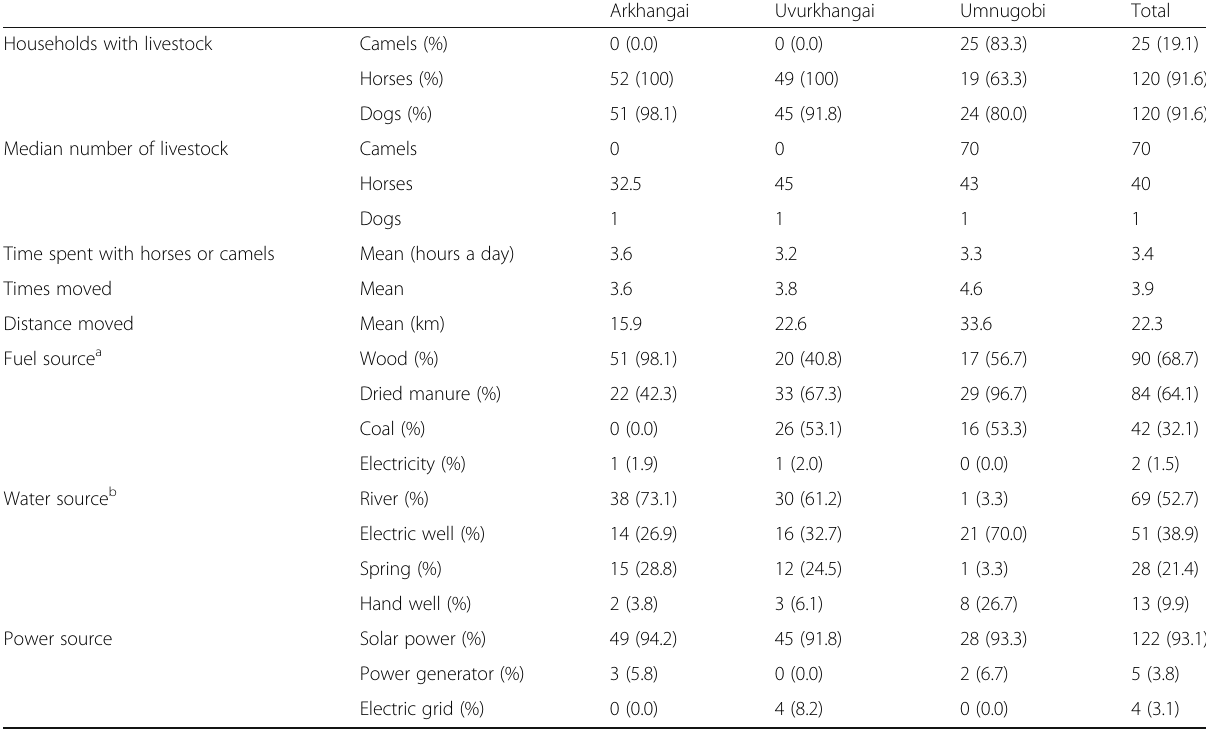
Table 2 Descriptive statistics for the participating survey households ( n = 131)